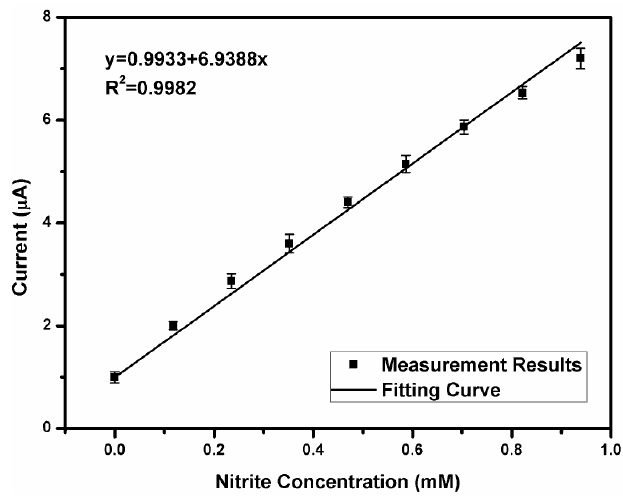
Figure 15. Nitrite concentration versus the detected current signals.